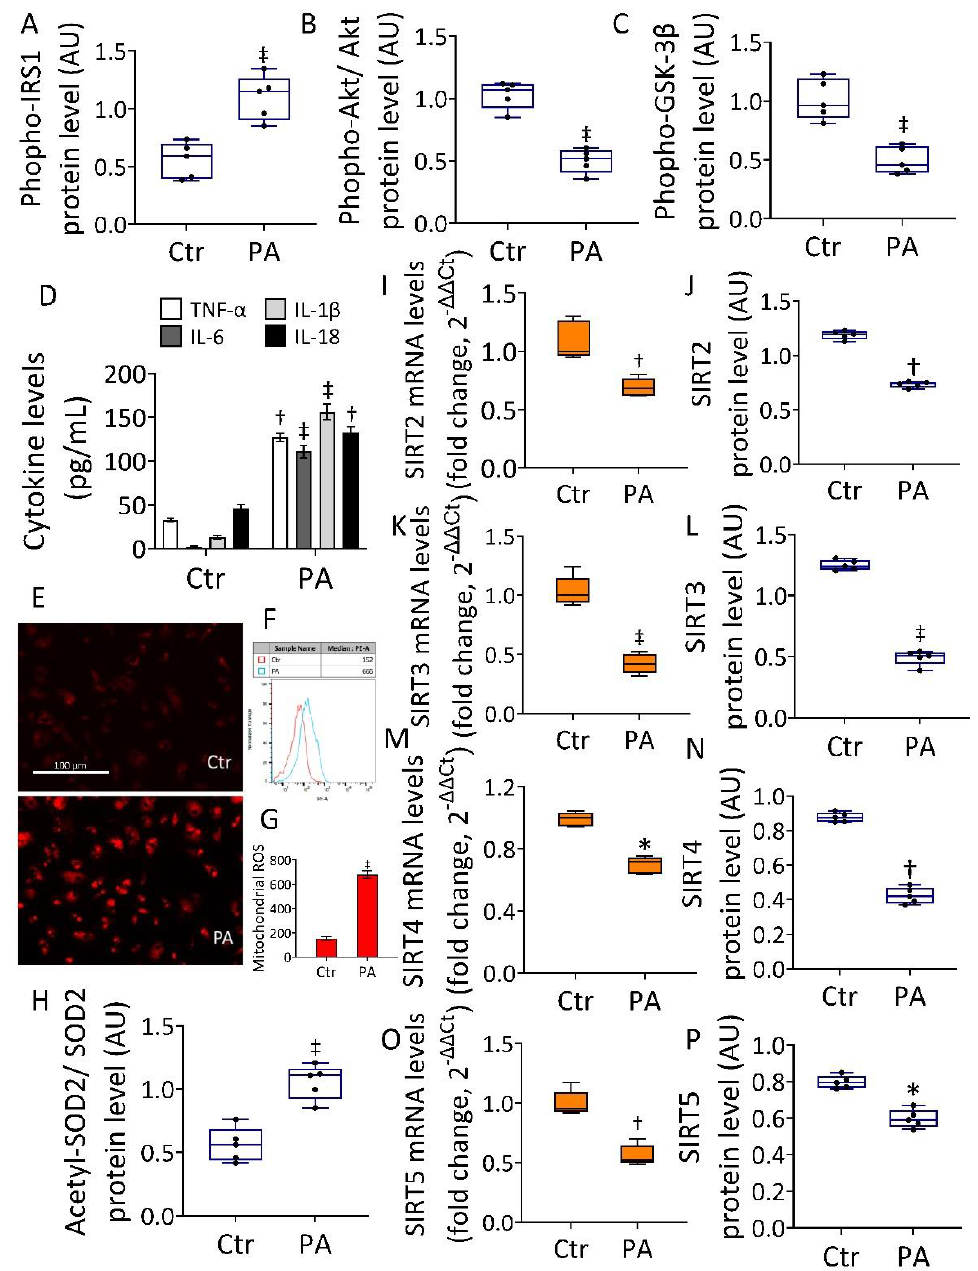
Figure 1. Effects of PA on IR and mitochondrial status. Immunoblotting analysis of ( A ) phospho-IRS1, ( B ) phospho-Akt/Akt, and ( C ) phospho-GSK-3 β . ( D ) Cytokine content and ( E – G ) representative images by fluorescence microscopy and FACS analysis of mitochondrial ROS detection expressed as fluorescence median ± SD ( n = 3). Scale bars = 100 µ m. ( H ) Acetylated-SOD2/SOD2 ratio. ( I , J ) SIRT2, ( K , L ) SIRT3, ( M , N ) SIRT4, and ( O , P ) SIRT5 mRNA and protein levels in EC exposed to 0.5 mM PA for 48 h or treated with the corresponding highest volume of HBSS-10 mM Hepes (Ctr). Western blotting results ( n = 5) are expressed as arbitrary units (AU), while mRNA levels ( n = 3) are reported as floating bars with a line representing the median ± SD. * p < 0.05 vs. Ctr; † p < 0.01 vs. Ctr; ‡ p < 0.001 vs. Ctr.